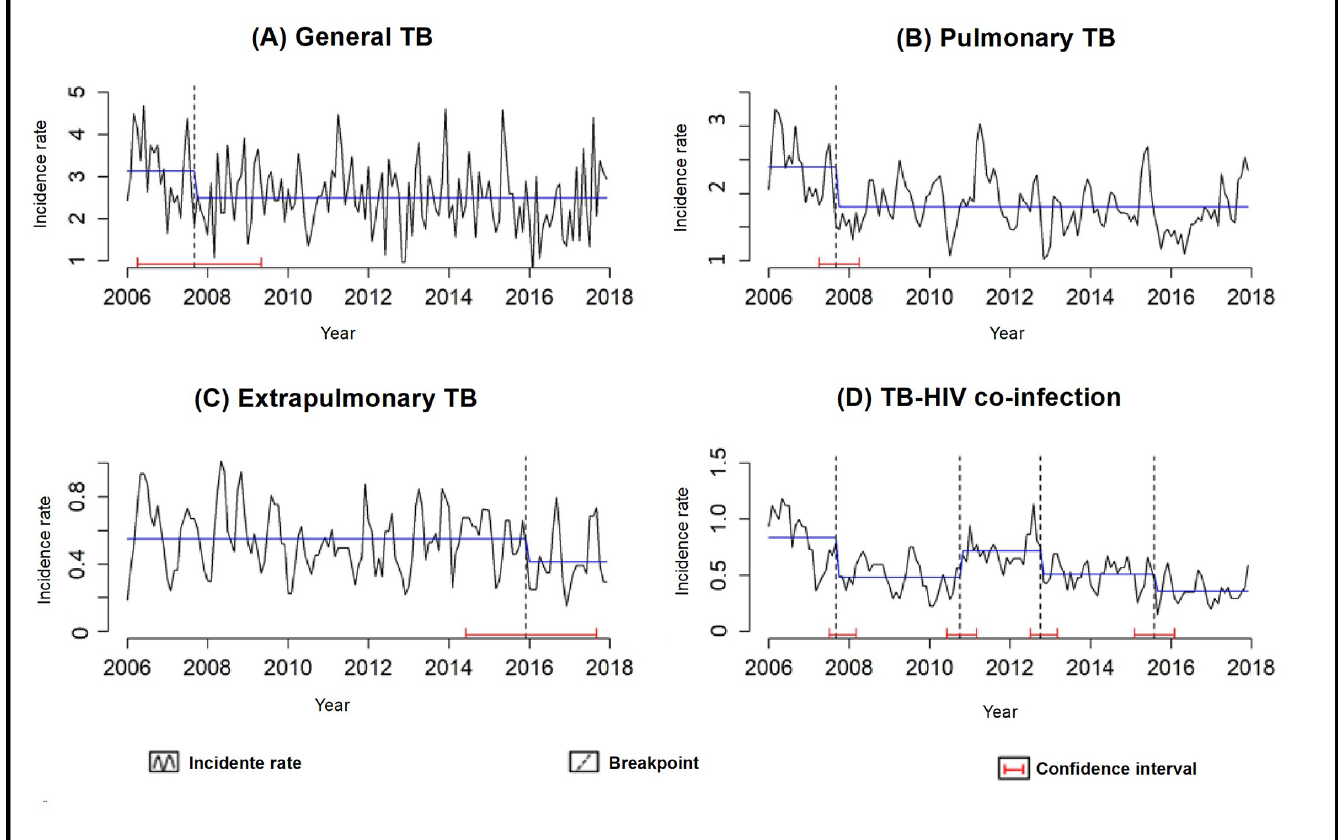
Fig 2. Changes in the structure of the time series regarding the incidence rates of tuberculosis in Ribeir ã o Preto, S ã o Paulo, Brazil (2006–2017).